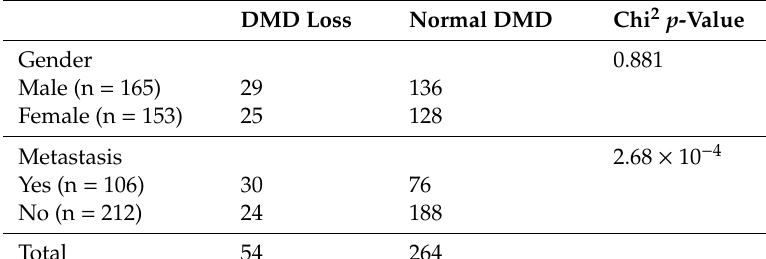
Table 2. Distribution of DMD deletion depending on gender or metastasis.